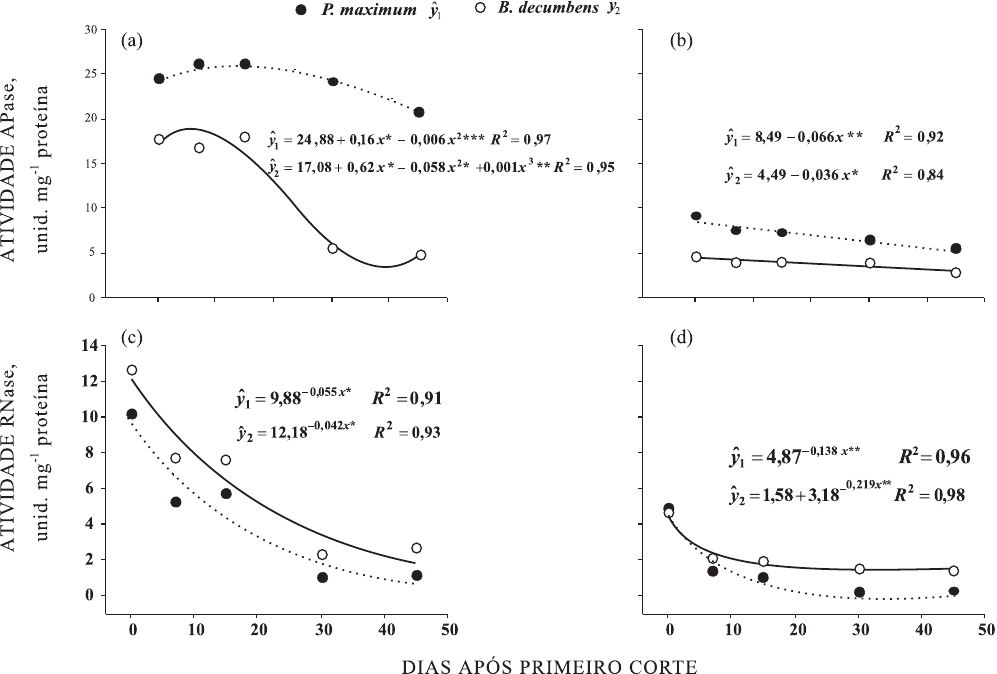
Figura 2. Atividade da fosfatase ácida - APase (a, b) e da Ribonuclease – RNase (c, d) na folha de Brachiaria decumbens e Panicum maximum para as doses de 100 (a, c) e 500 mg dm -3 (b, d) por ocasião do primeiro corte (tempo zero), e até 45 dias após. ***,**,*: significativo a 0,1, 1 e a 5 % pelo teste